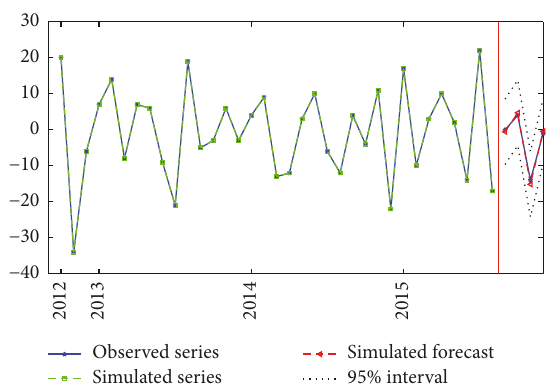
Figure 9: The actual, fitted, and forecasted series by hybrid model for number of